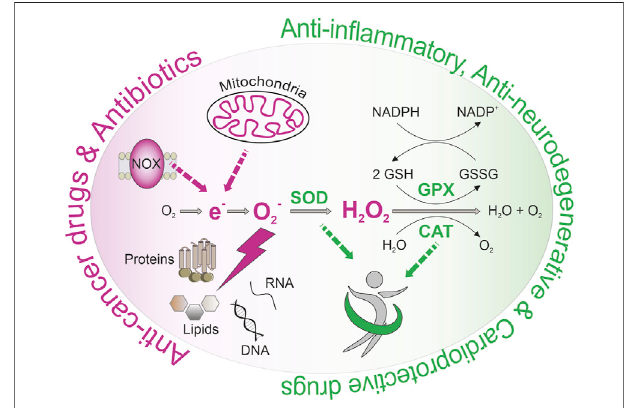
FIGURE 1 | Intracellular ROS homeostasis affecting health and